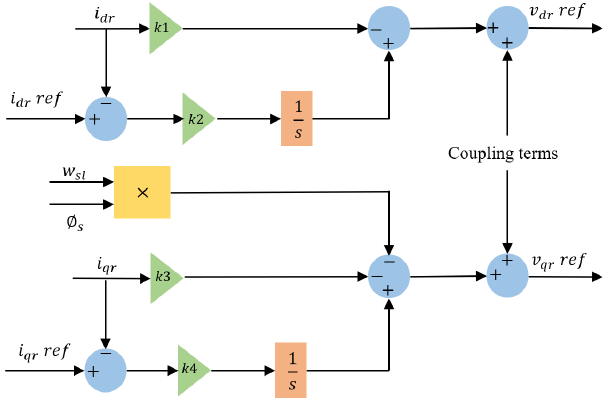
Figure 7. Functional block diagram of LQR applied to DFIG [20].